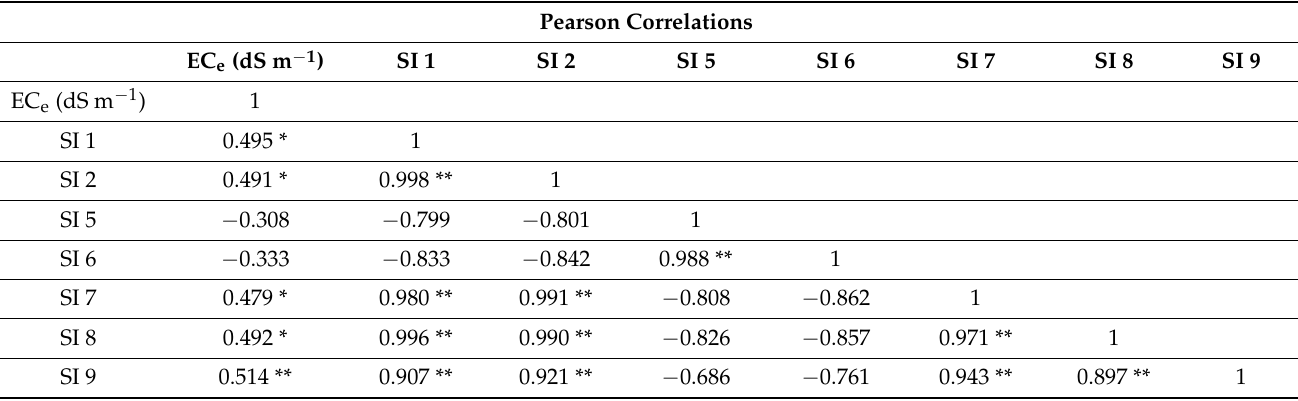
Table 5. Correlation matrix among soil salinity indices and soil EC e . Pearson